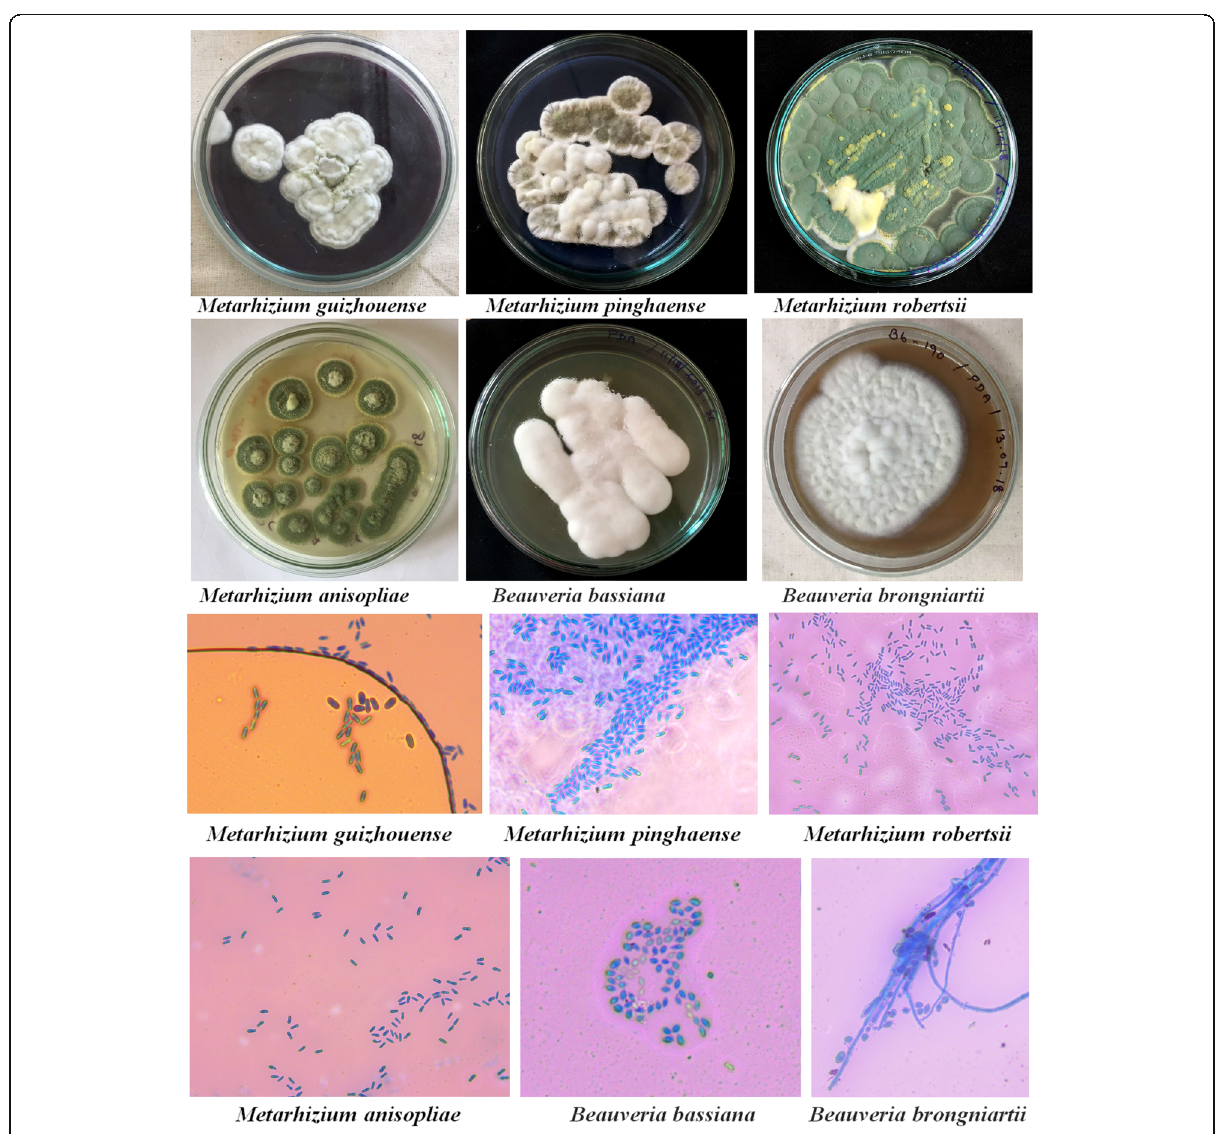
Fig. 1 Colony and conidial morphology of entomopathogenic